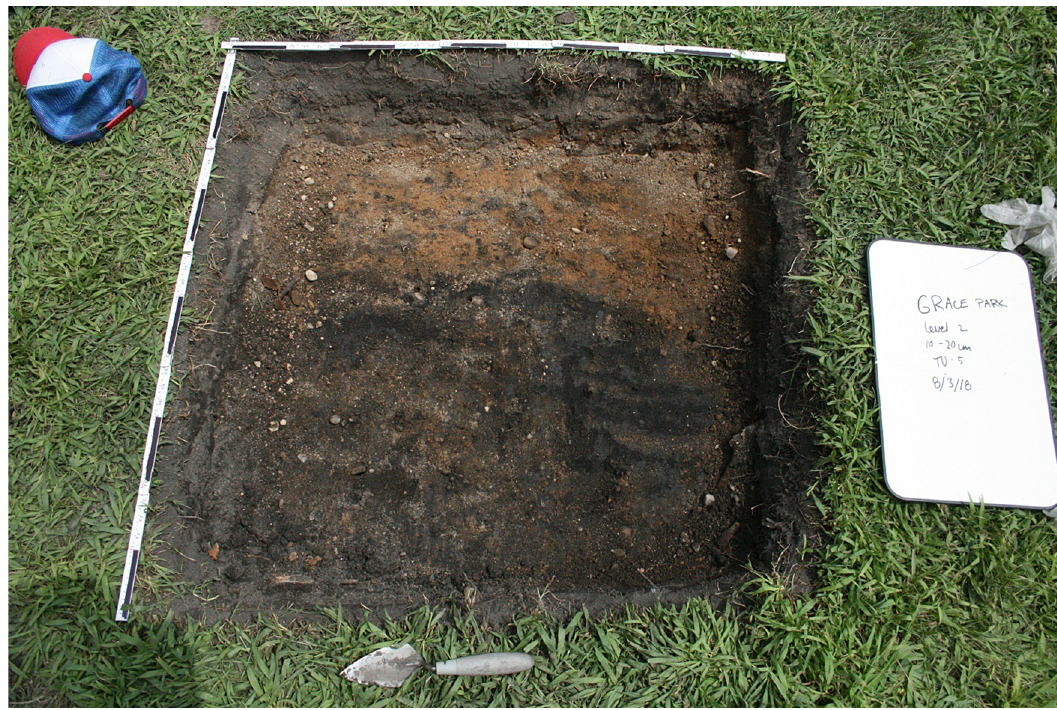
Figure 5: Planview of test unit 5, facing east. Example of sandy, iron - rich subsoil in the top half of the unit fl